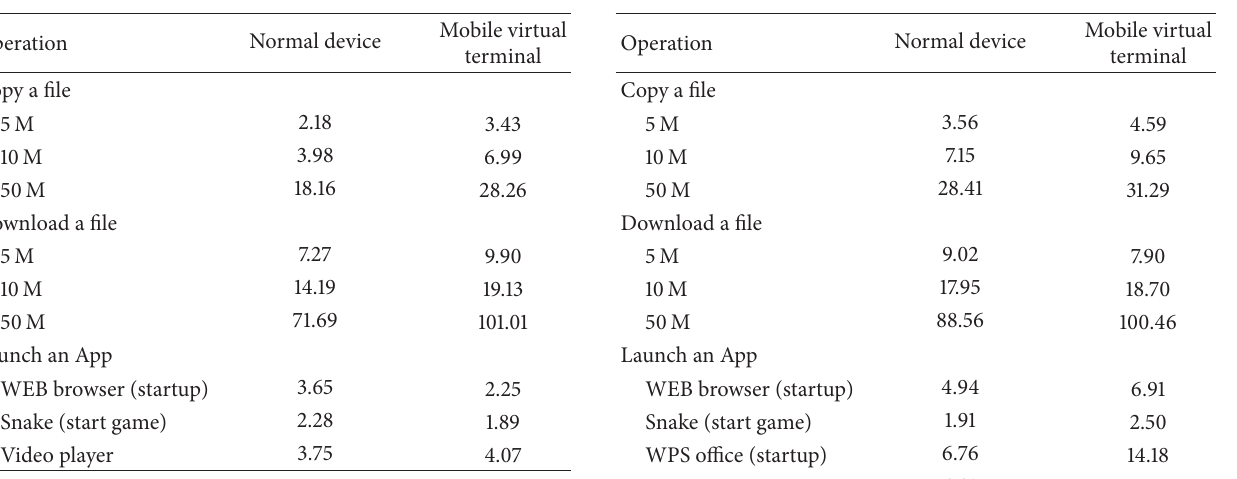
Table 1: Operation latency in Linux (seconds). Table 2: Operation latency in Android